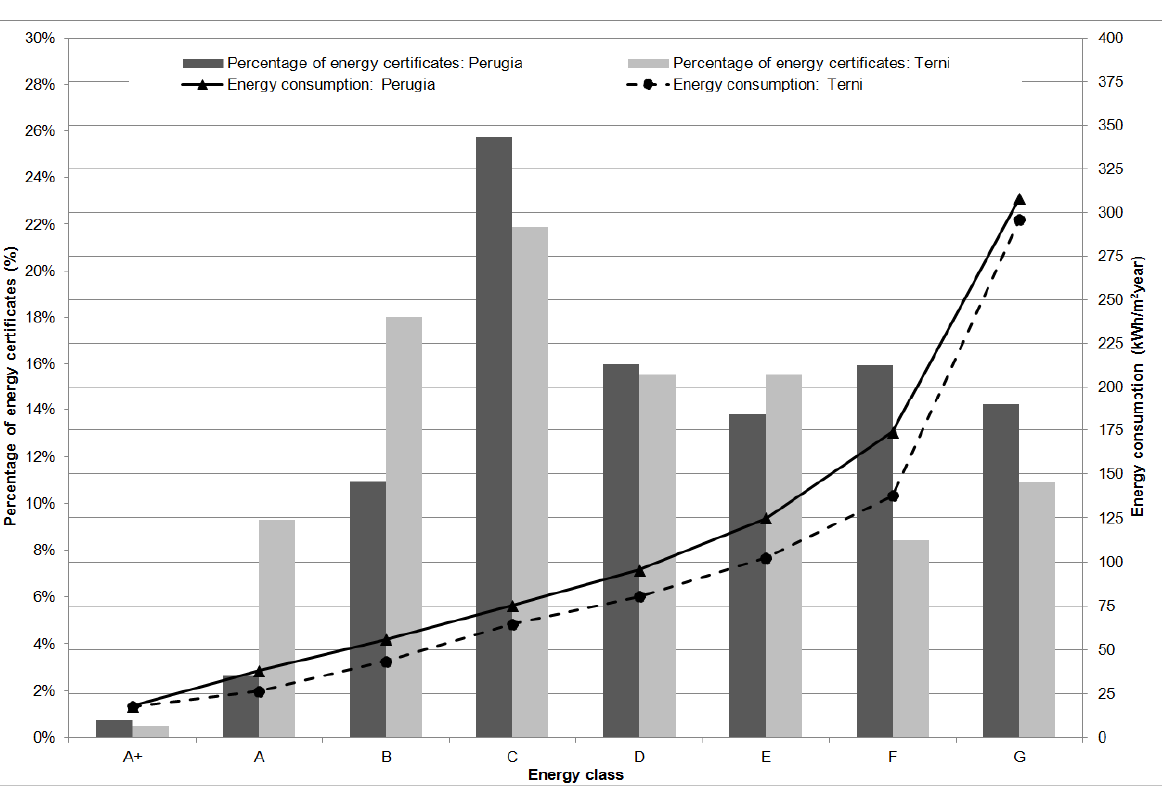
Figure 2. Percentage of energy certificates received and mean energy consumption as a function of the energy performance class of Umbria